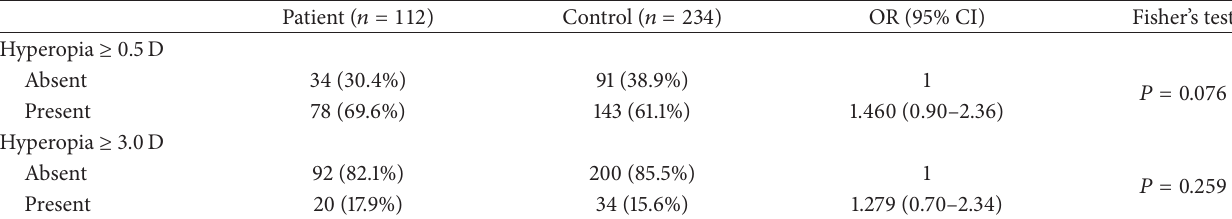
Figure 1: Flowchart for selecting PACG patients and controls. REH = Rotterdam Eye Hospital. Table 2: Hyperopia defined as a refractive error spherical equivalent (SE) ≥ 0.5 dioptres (D) for the main outcome and SE ≥ 3.0 D for a subanalysis. Odds ratios (OR) and their 95% confidence intervals (CI) are shown. Results of the one-sided Fisher’s test 𝑃 < 0.05 were assumed to be